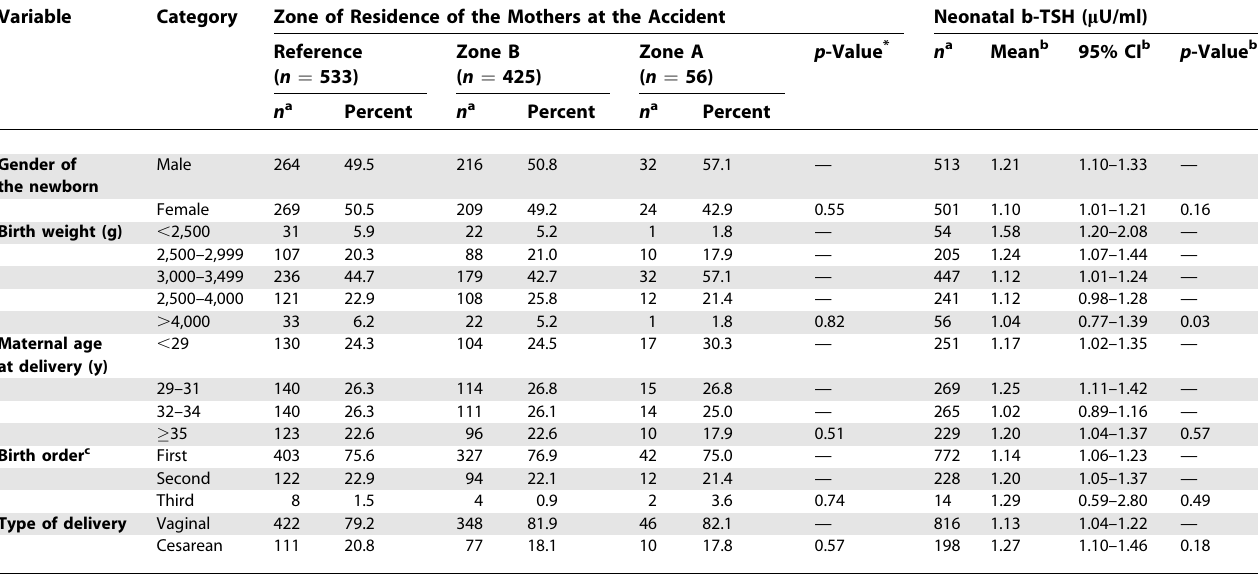
Table 1. Characteristics, Dioxin Contamination Zones, and Neonatal b-TSH Levels of the Mother–Child Pairs Included in the 1994–2005 Seveso Population-Based Study